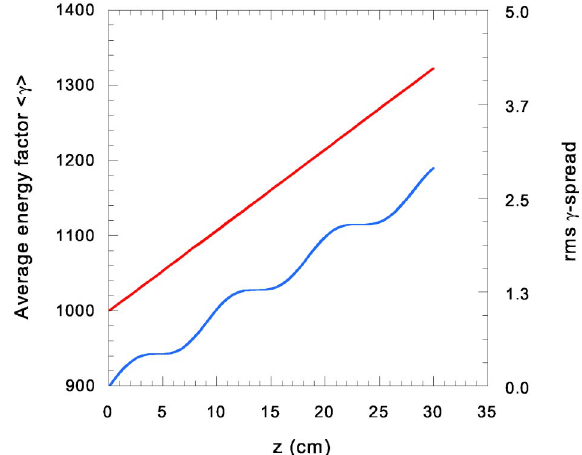
FIG. 20. (Color) Dependence of average energy factor h (cid:15) i and rms (cid:15) spread on axial distance z . The bunch of test particles is accelerated from h (cid:15) i (cid:3) 1000 (510.5 MeV) to 1322.3 (675.2 MeV) over a 30-cm distance, with an energy gain of 164.7 MeVand a final rms (cid:15) spread of 2.9 (1.5 MeV). It is seen that the energy spread increases much more slowly around the focusing planes ( z (cid:3) 4 : 6 , 13.2, and 23.6